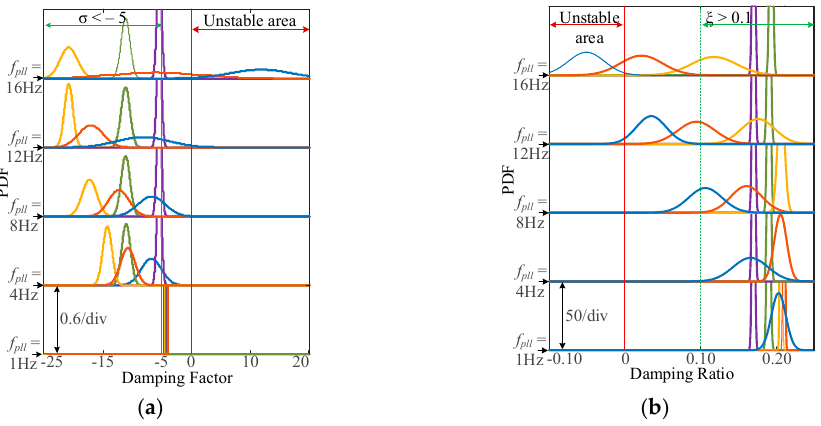
Figure 10. Probability density functions (PDFs) of stability indices for different grid SCRs and PLL bandwidths. ( a ) PDFs of the maximum damping factor; ( b ) PDFs of the minimum damping ratio. Colors correspond to different grid SCRs in Figure 6a.